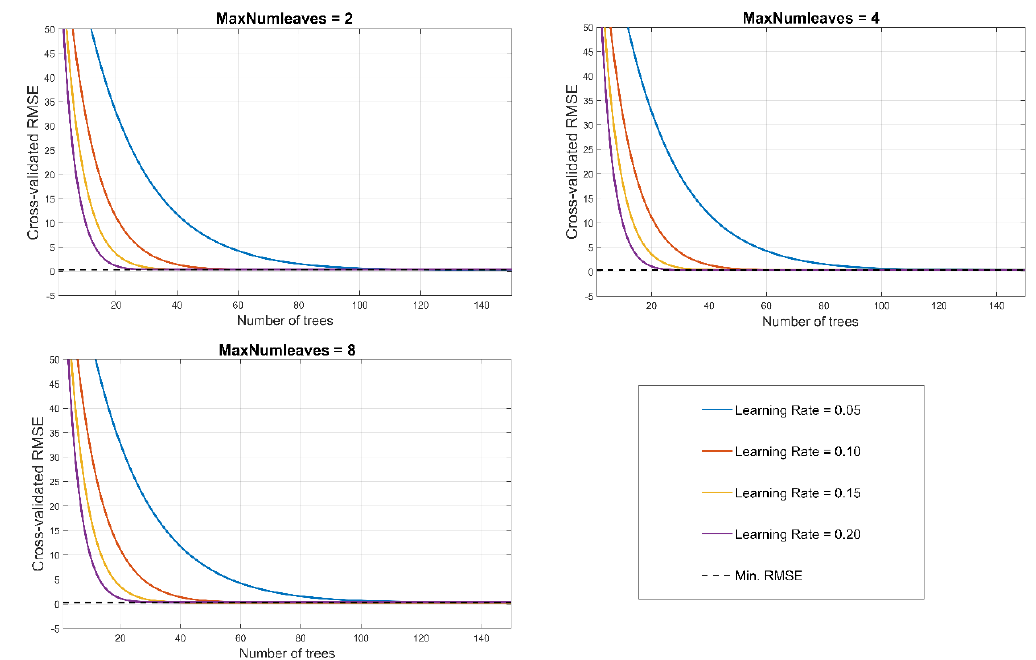
Figure 7. Impact of hyperparameters on improving prediction error. Although the difference between RMSE in N = 30 and N = 100 is marginal (RMSE30 = 0.319412, RMSE100 = 0.290187), and it is not clear in figure, the best prediction accuracy N = 100, L = 8 and R =.02 was selected by MATLAB function.